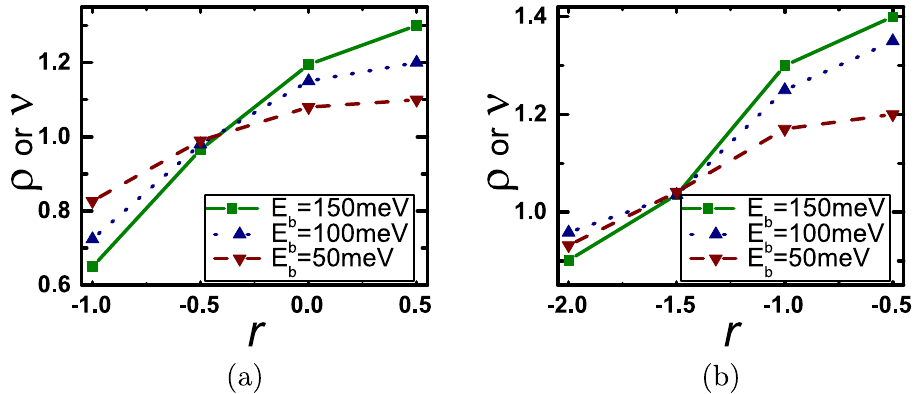
Figure 6. Analysis of performance improvement in thermoelectric generators via energy filtering under the condition I Qp ≫ I Qe (heat conduction dominated by phonon). Plot of ρ vs. r for ( a ) a single moded square nanowire of length 20 nm and width 2.7 nm and ( b ) a bulk generator of length 20 nm . The generators are embedded with a Gaussian energy barrier ( σ w = 2.7 nm ). Plots are shown for three different energy barrier heights ( E b